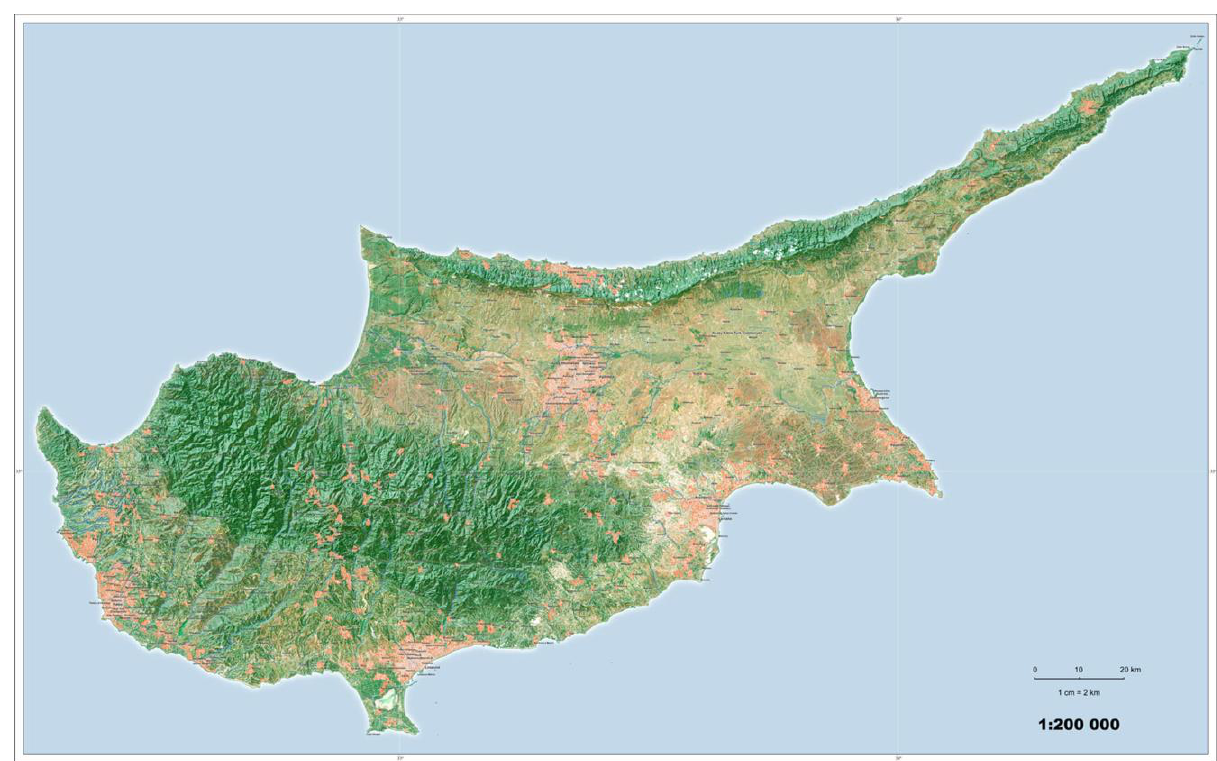
Figure 11. Map of Cyprus at scale 1:200 000 reduced here to scale approx. 1:1.6